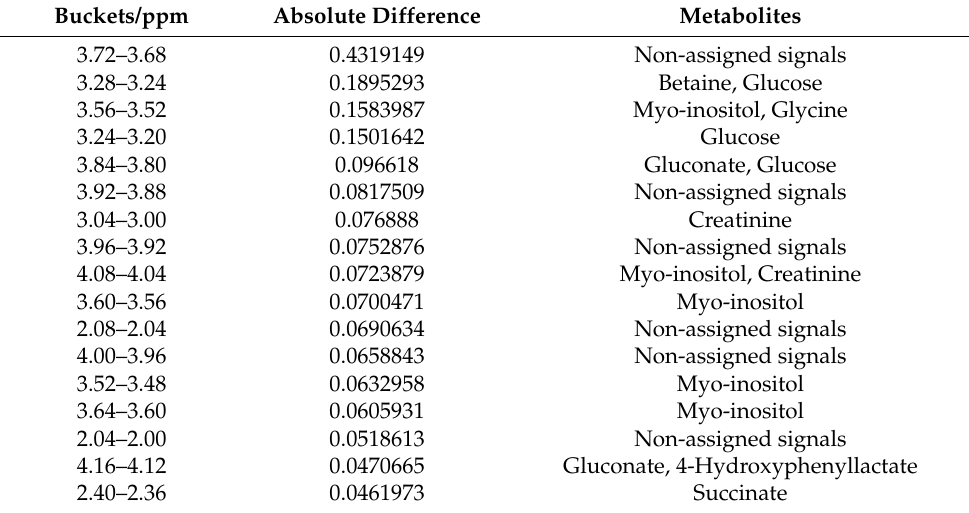
Figure 6. Loading plot (factor 1 vs. factor 2) of the third mode (subjects) in the PARAFAC-2 model. Labels correspond to the gestational age at birth group E = extremely preterm (less than 28 weeks of gestation); V = very preterm (28 – 32 weeks); and M = moderate to late preterm (32 – 37 weeks). Table 3. Buckets ´ chemical shifts associated with the absolute difference between the mode 2 factors of the PARAFAC-2 model and their corresponding metabolites in the studied preterm newborns.